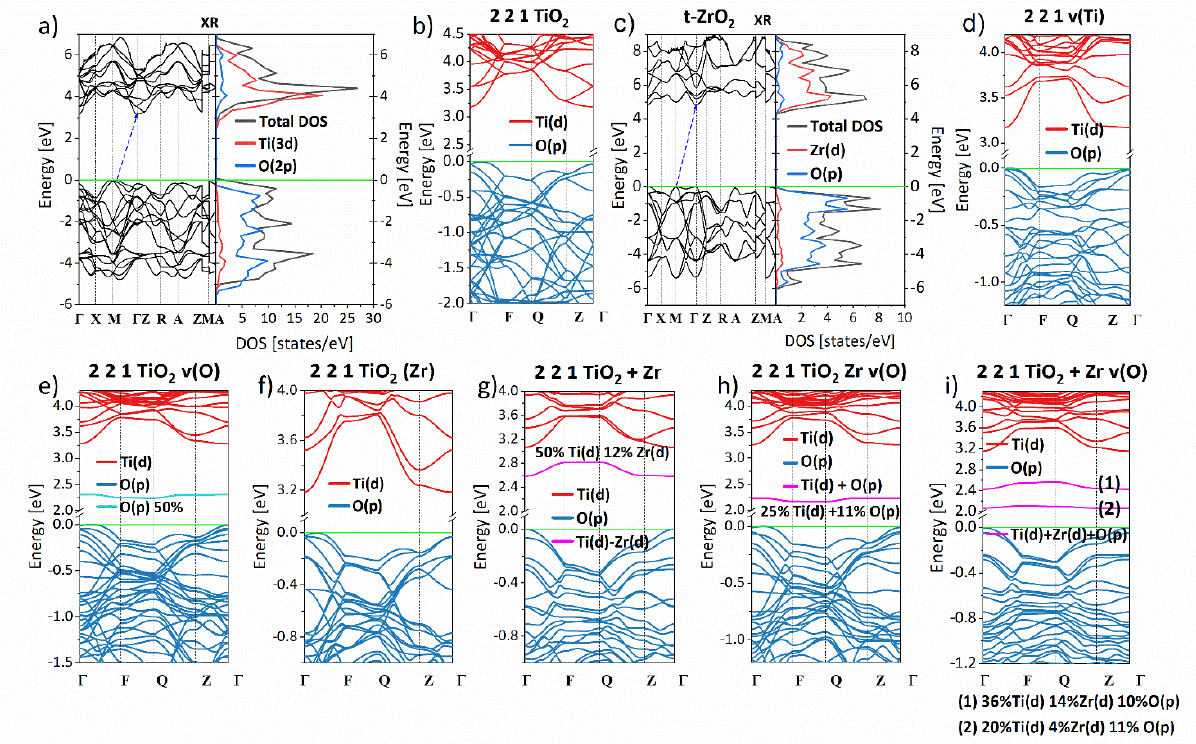
Figure 2. Energy band structure calculated by DFT/PBE+U method for: a-TiO 2 crystal in primitive unit cell representation ( a ), a-TiO 2 supercell (2 × 2 × 1 TiO 2 ) ( b ), t-ZrO 2 crystal ( c ), defected a-TiO 2 crystal with titanium vacancies ( d ) and oxygen vacancies ( e ), a-TiO 2 supercell doped by Zr substituting Ti atom ( f ) and in interstitial position ( g ), a-TiO 2 doped by Zr atoms substituting Ti atoms ( h ) and in interstitial position ( i ) additionally possessing oxygen vacancies.